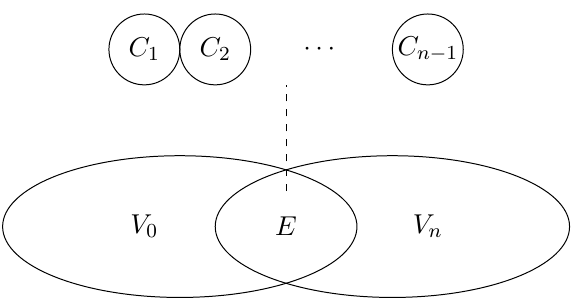
Figure 3 . The geometry of S p . V i is birationally equivalent to C i fibration over E where C i is rational. V and V are rational 0 n